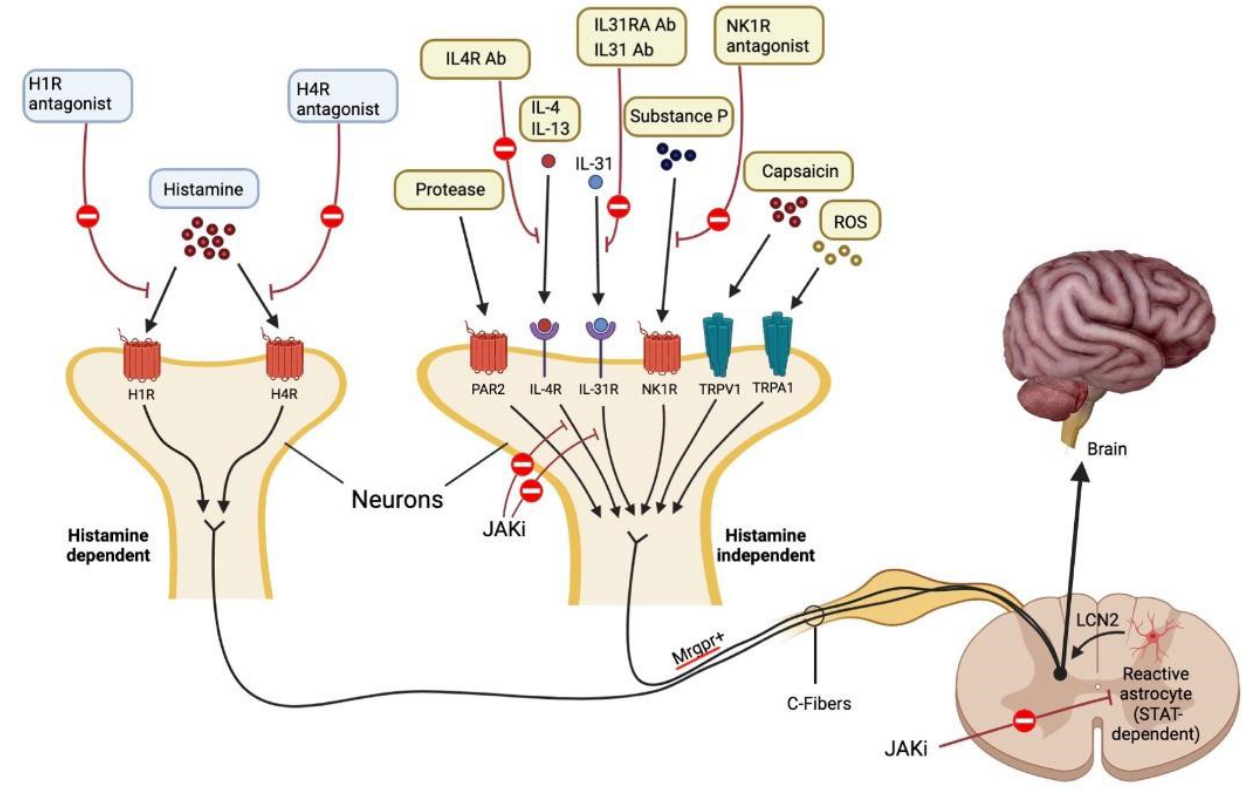
Figure 2. Mechanisms that cause itch. Each pruritogen involved in AD has a unique receptor that causes itching. It is believed that people with AD experience pruritus through both H1R1 histamine-dependent and Mas-related G protein-coupled receptor (Mrgpr)1 histamine-independent signaling pathways. Lipocalin 2 (LCN2), which is produced by STAT3-dependent reactive astrocytes in the spinal dorsal horn and sensitizes a network of GRPR1 neurons involved in the processing of itch, causes chronic pruritus. Each antipruritic medication blocks a different pruritic route, as depicted in the diagram. JAK-STAT signaling causes IL-4, IL-13, and IL-31 to perform their specific tasks. Protease-activated receptor 2 is abbreviated as PAR2. Adapted from: Paller et al. [35]. Janus kinases (JAKs) are a family of kinases that include JAK1, JAK2, JAK3, and tyrosine kinase 2 (TYK2); JAKs mediate cytokine signaling by activating signal transducer and activator of transcription (STAT) transcription levels. The JAK/STAT pathway is activated in a variety of disease states